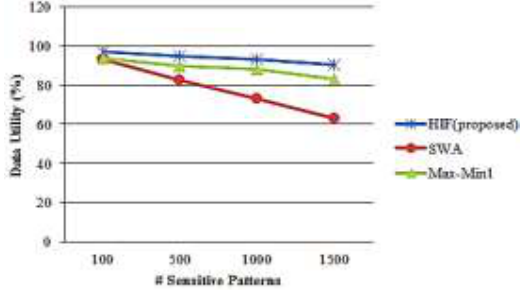
Figure 4. Number of lost patterns produced by HIF, Max- Min1 and SWA.